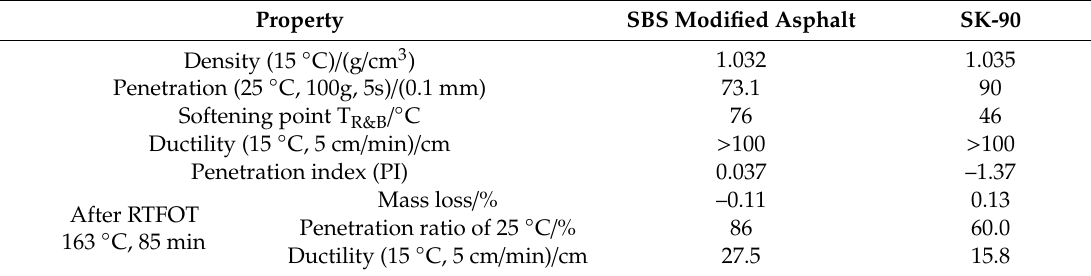
Table 2. Physical properties of base asphalt and modified asphalt.